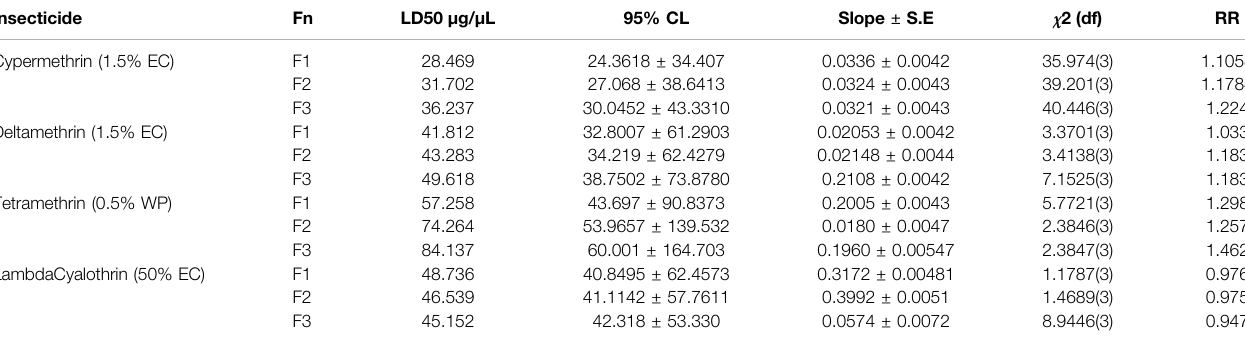
TABLE 2 | Evaluation of resistance of pyrethroid insecticides in Musca domestica from district Jhang. Insecticide Fn LD50 µg/µL 95% CL Slope ± S.E χ 2 (df) RR Cypermethrin (1.5% EC)